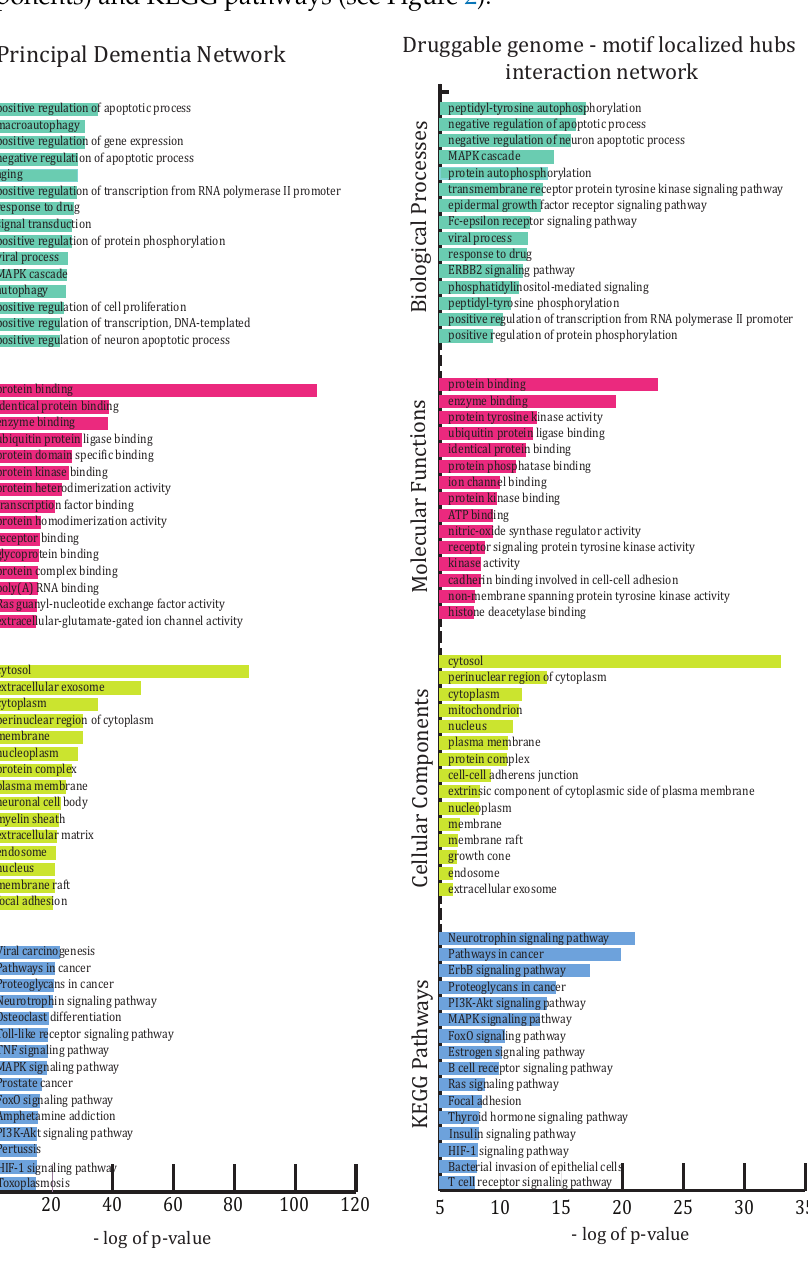
Figure 2. This figure illustrates the highly enriched gene ontology categories (biological processes, molecular functions, cellular components and KEGG pathways) in the principal dementia network and resultant “druggable genome–motif-localized hubs/stability” network. The most abundant GO-BP groups were concerned with biological regulation (posi- tive and negative regulation of apoptotic process, positive regulation of gene expression, positive regulation of transcription from RNA polymerase II promoter, etc.), metabolic processes (aging, response to drug, response to lipopolysaccharide, inflammatory